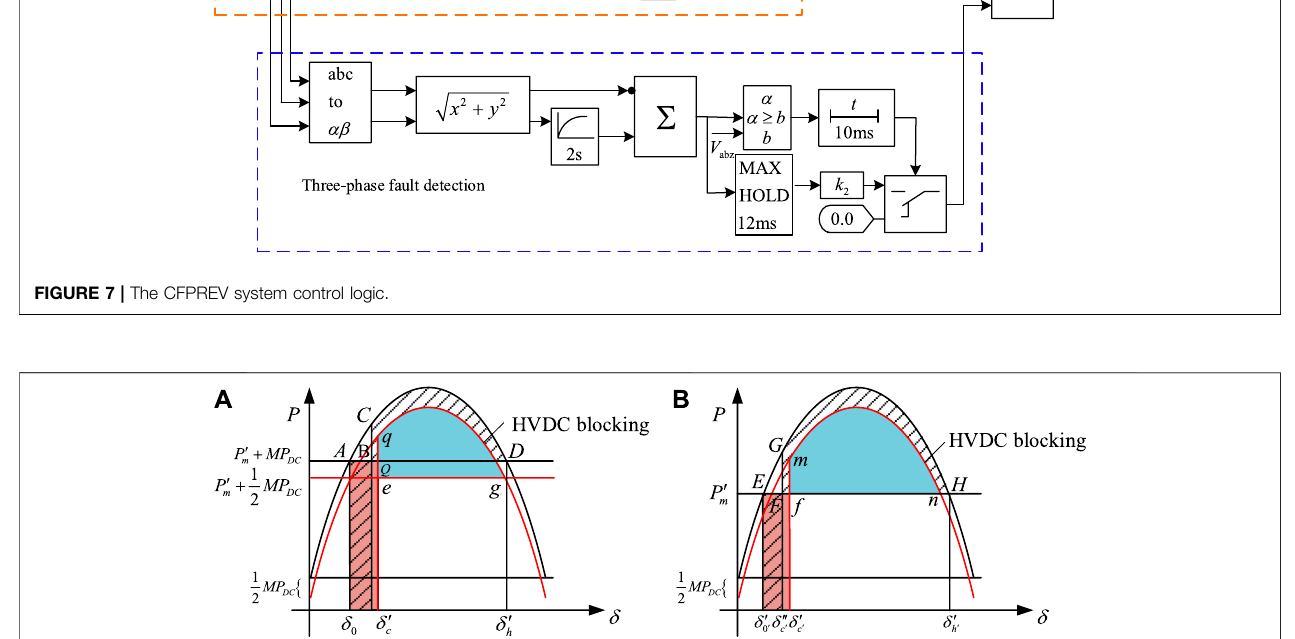
Frontiers in Energy Research |